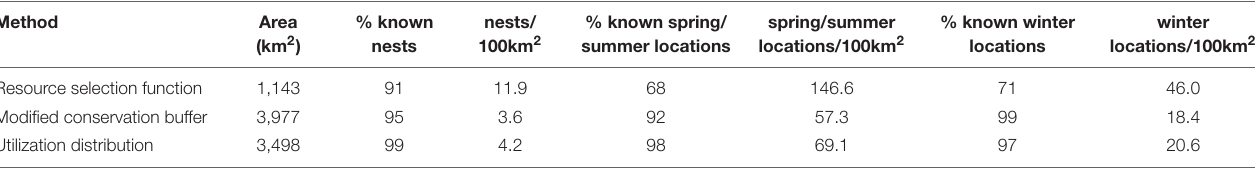
TABLE 8 | Comparison of priority areas generated via different